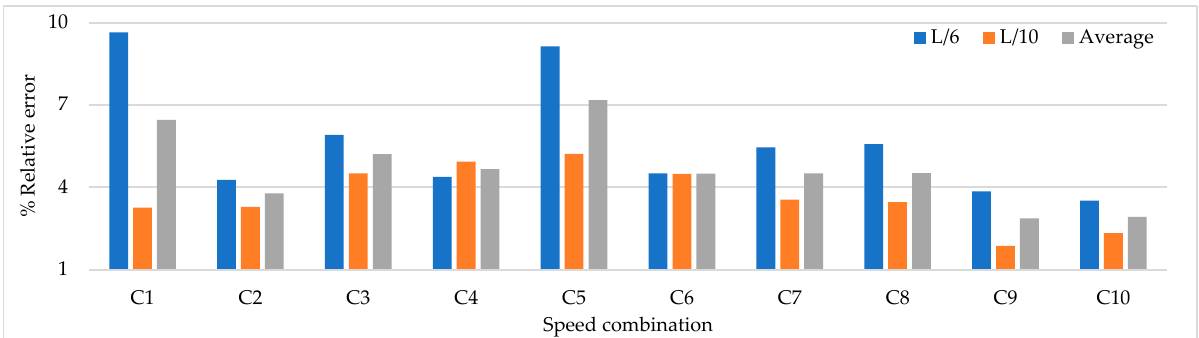
Figure 9. MAC index results for speed combinations for sensor-to-sensor separation distances of L/6 and L/10.